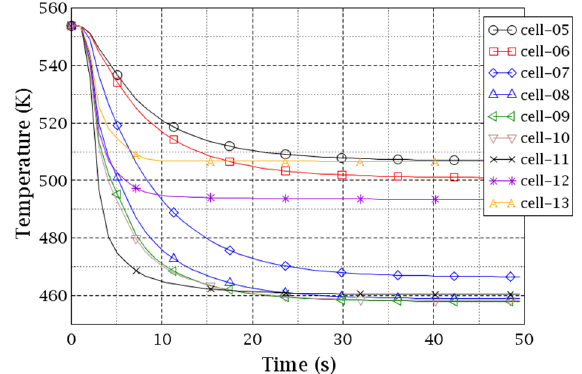
Figure 25. Evolution of the coolant temperature distribution at the core outlet of the AP1000 reactor CA-V cold-part (cell index is from Figure 21).